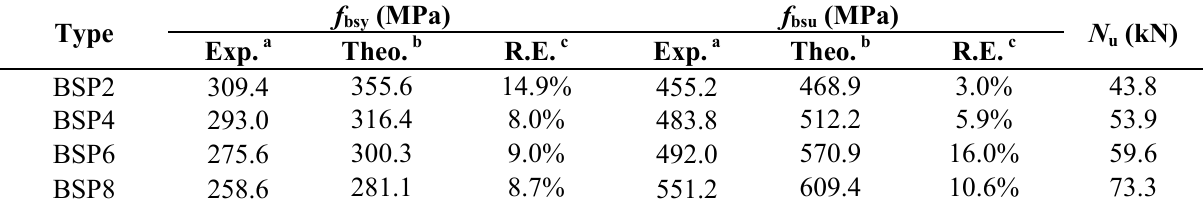
Table 4. Strength and ultimate bearing capacity of BSP under uniaxial tension.